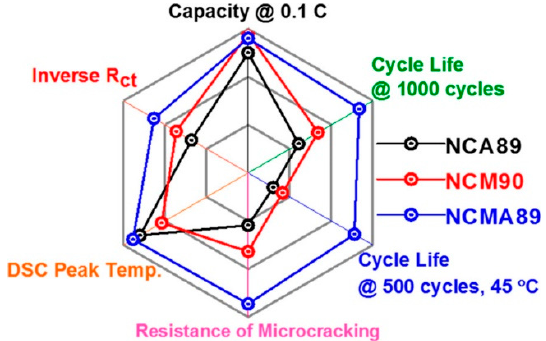
Figure 10. Spider chart of electrochemical performance of Li[Ni 0.89 Co 0.05 Mn 0.05 Al 0.01 ]O 2 (NCMA89). Reproduced with permission from [246]. Copyright 2019 The American Chemical Society.